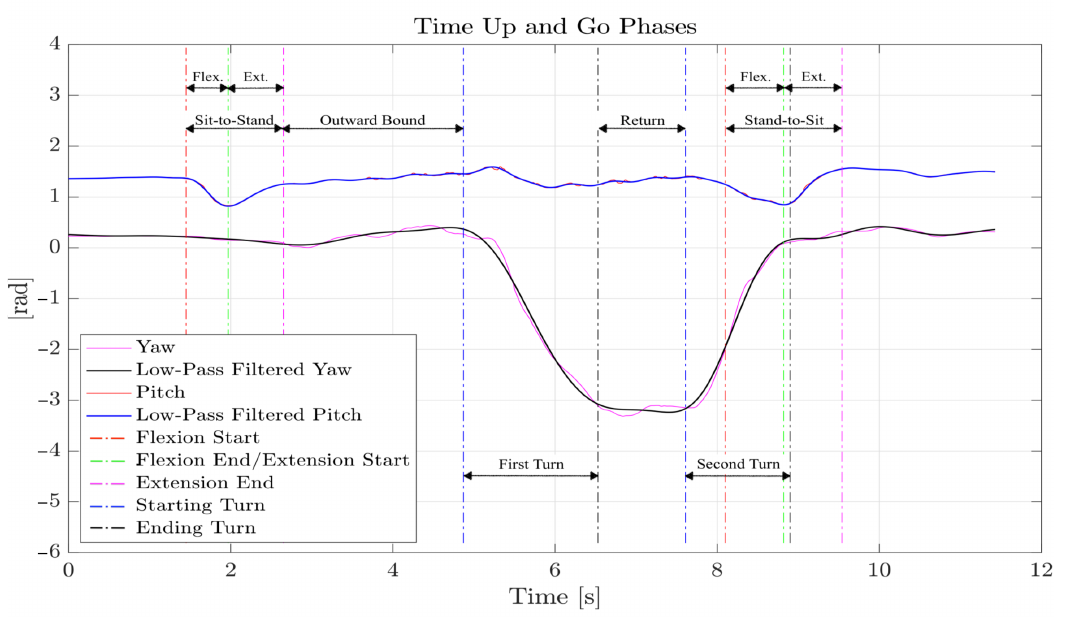
Figure 8. TUG phases obtained from MTw data (male